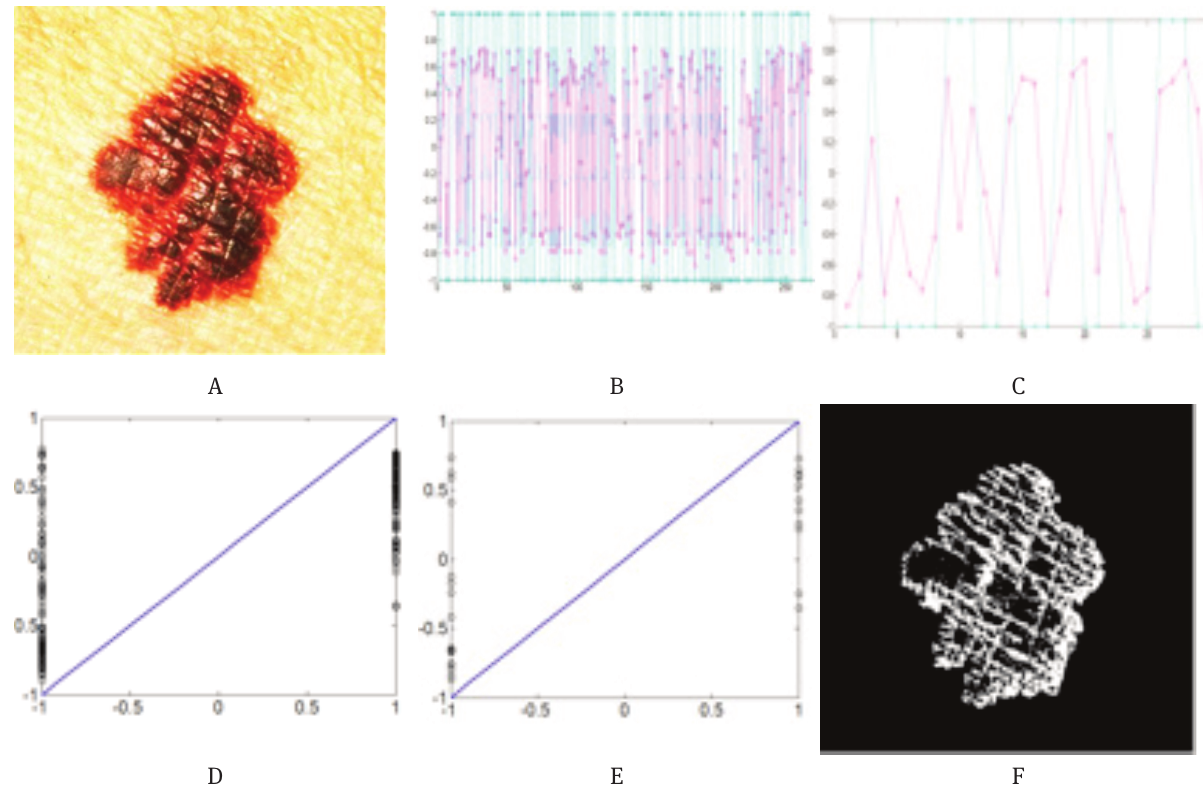
Figure 5: (A) input image, (B) and (C) train and test approximation resemblance (red: original and blue: approximation) respectively, (D) and (E) classified train and test data, (F) output melanoma segmented image